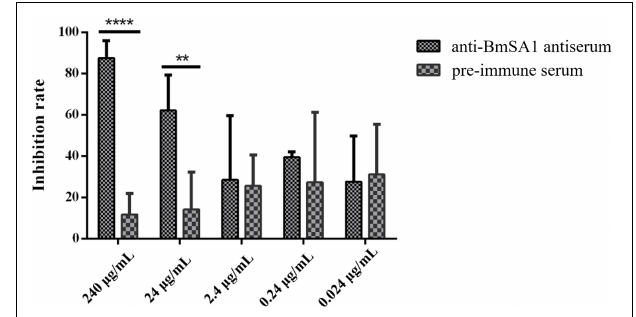
FIGURE 6 | Anti-BmSA1 antiserum neutralization test. Polyclonal anti-BmSA1 antiserum and a negative control (pre-immune serum) were added to B. microti in vitro culture. The differences between anti-BmSA1 and pre-immune serum in the relative percentages of invasion were examined by the One-way ANOVA, and P values are indicated ( ∗ P < 0.05, ∗∗ P < 0.01, ∗∗∗ P < 0.001, ∗∗∗∗ P < 0.0001).